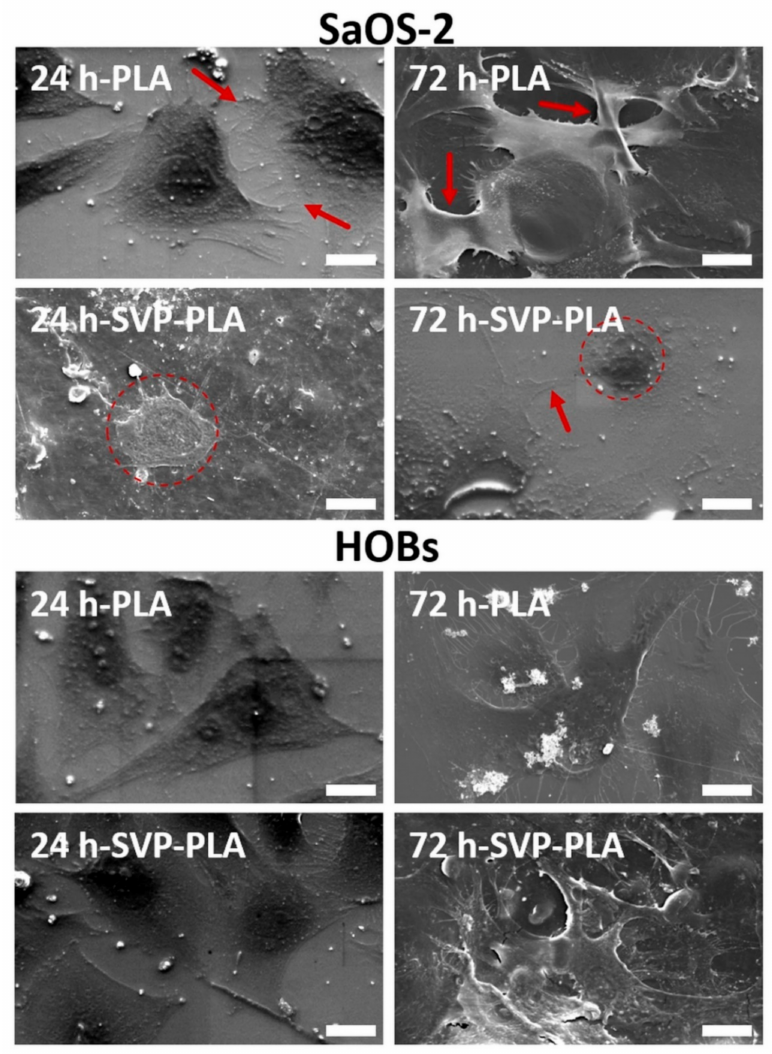
Figure 7. SEM images of SaOS-2 cells and HOBs on neat PLA and SVP-PLA composite at 24 h and 72 h (Scale bars: 20 µ m). After 72 h, the filopodia formation was followed by a strong cell–cell connection (shown by red arrows) on a neat PLA patch. (Magnification: 2000 ×